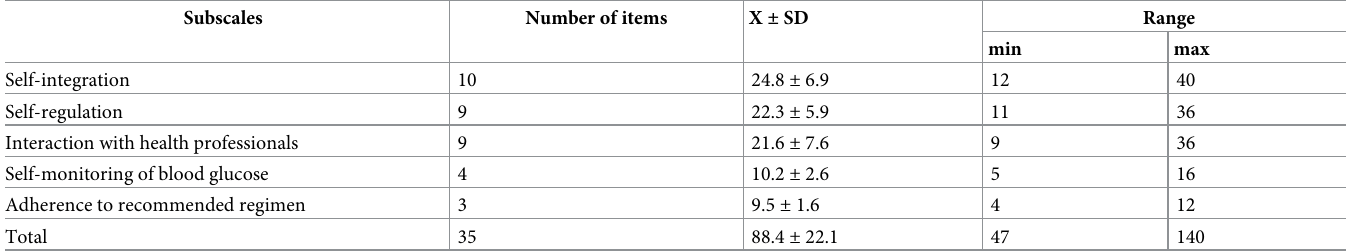
Table 2. Diabetes self-management scores and internal